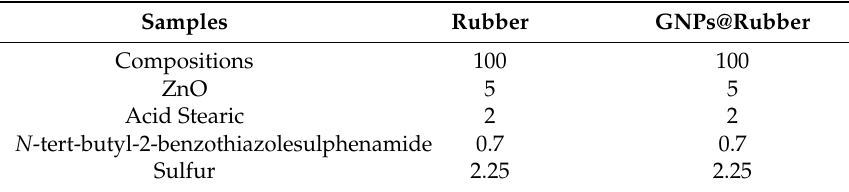
Table 1. Formulations of graphene nanoplates (GNPs)/NRL